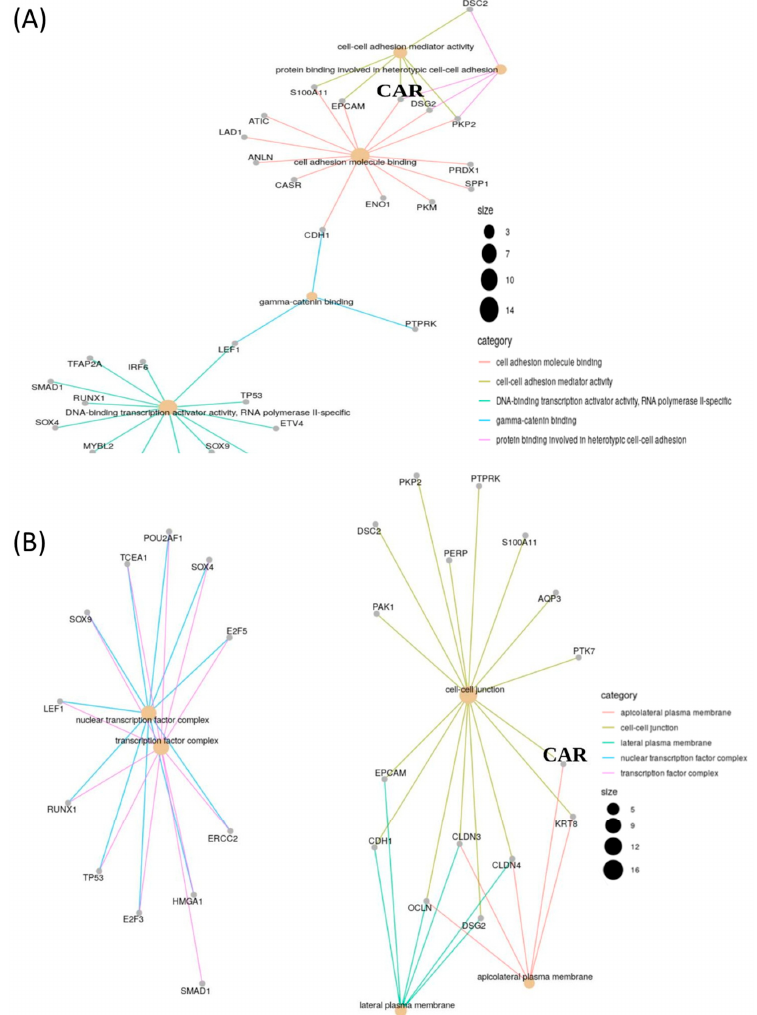
Figure 2. Clinical value of CAR gene expression in lung adenocarcinoma (LUAD) that presents an elevated level in concordance with various genes, as shown by gene ontology. ( A ) Molecular function and ( B ) cellular component.